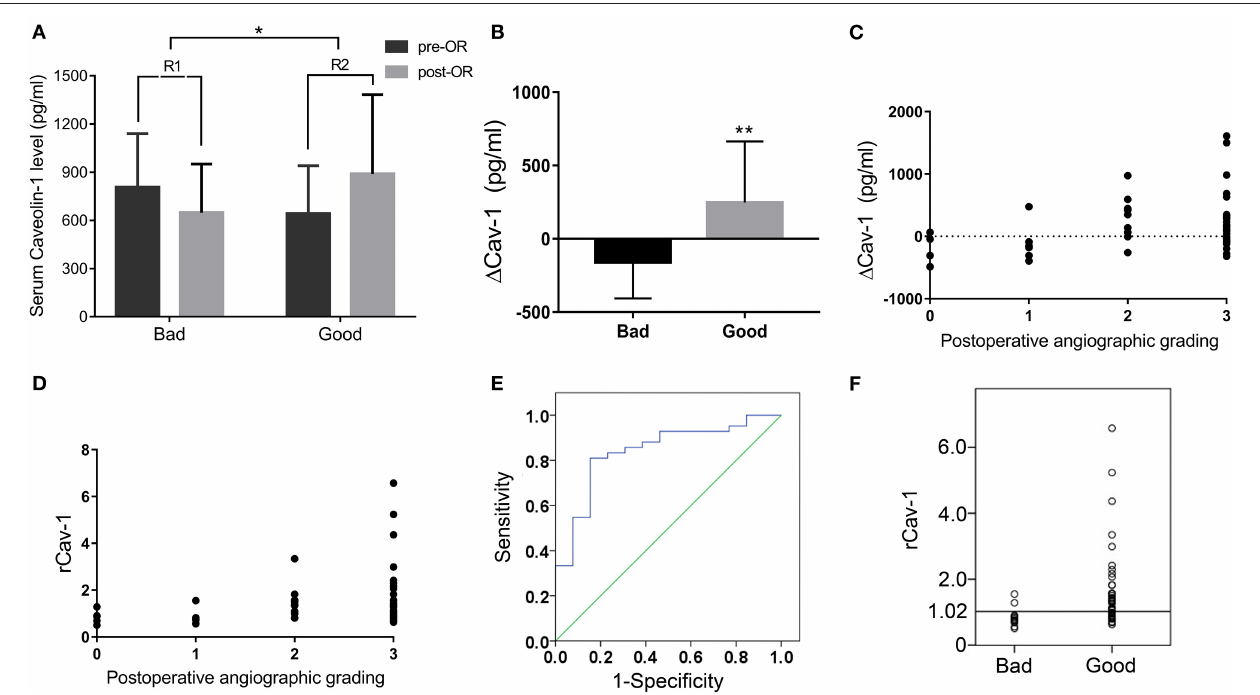
FIGURE 2 | Serum Cav-1 increase after operation indicated good collateral circulation by digital subtraction angiography (DSA). (A) Preoperative and 6 months postoperative serum Cav-1 levels in both the bad and good compensation groups. The rCav-1 increased in the good compensation group (R2) and differed considerably from the bad compensation group (R1). (B) The 1 Cav-1 value in the bad and good compensation groups, respectively. (C,D) 1 Cav-1 and rCav-1 were positively correlated with the postoperative angiographic grading by the Spearman’s correlation analysis ( r = 0.3586, p = 0.0072; r = 0.3784, p = 0.0044, respectively). (E,F) The receiver operating characteristic (ROC) curve and cutoff value of rCav-1 in the bad and good compensation groups. The area under the curve was 0.841 ( p < 0.0001), and the rCav-1 cutoff value was set at 1.02 with sensitivity at 71.4% and specificity at 84.6%. 1 Cav-1: postoperative serum Cav-1